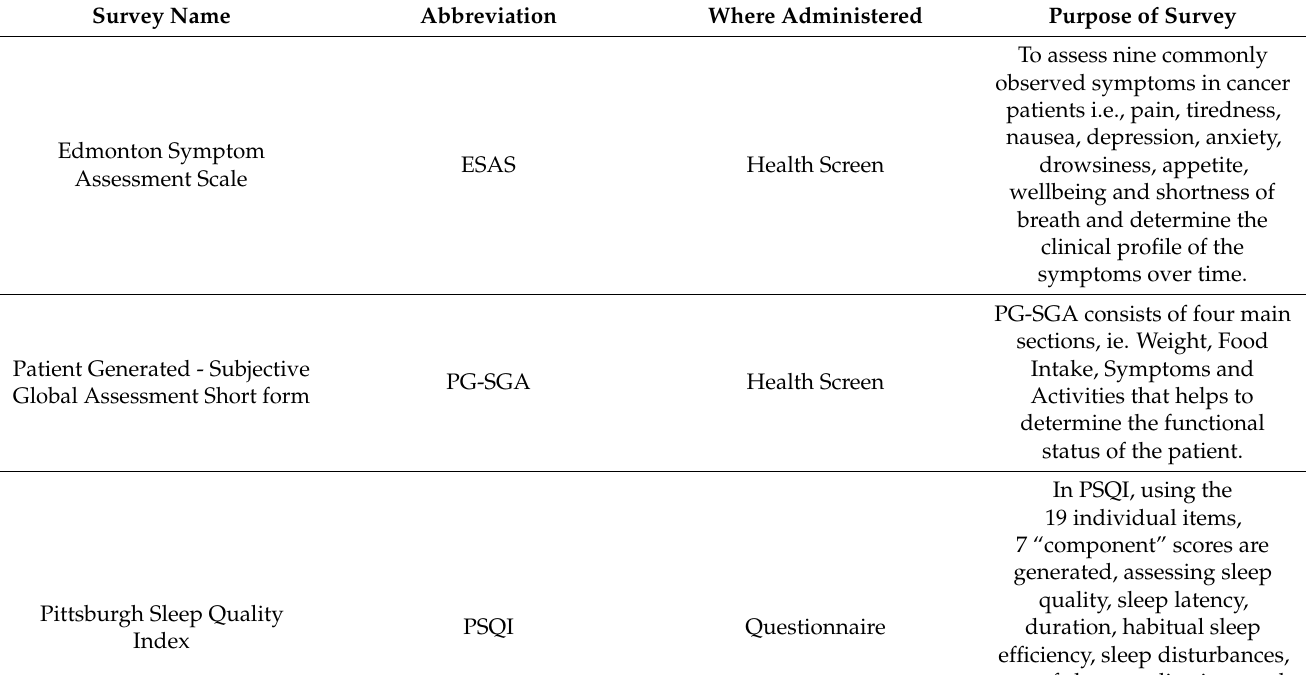
Table 3. Validated instruments incorporated into the FPC health screen or comprehensive